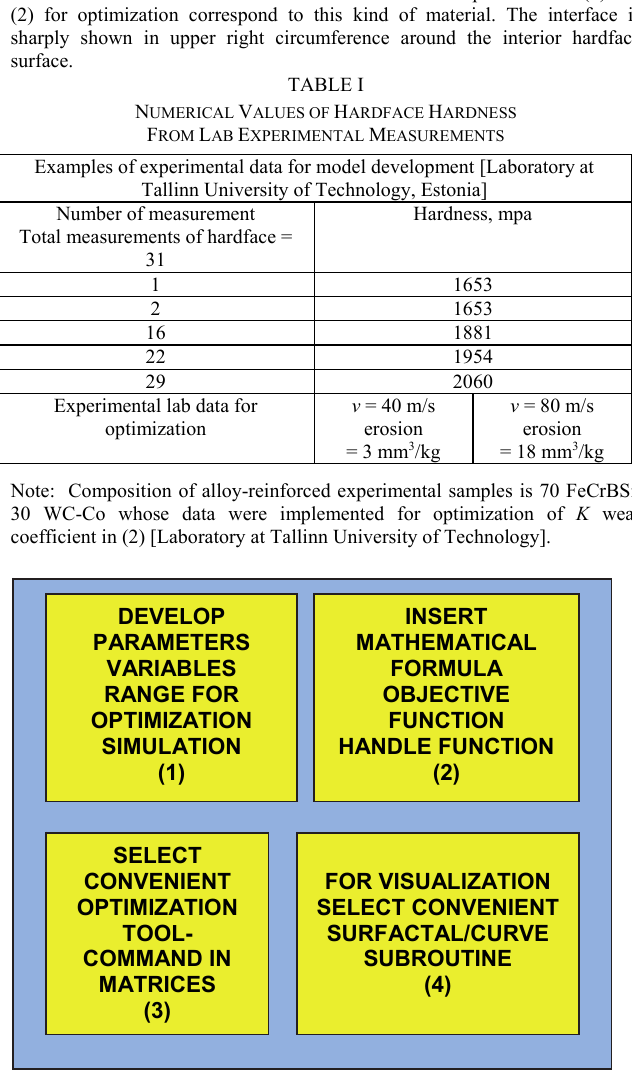
Fig. 4. Flow chart of a graphical optimization program (basic).